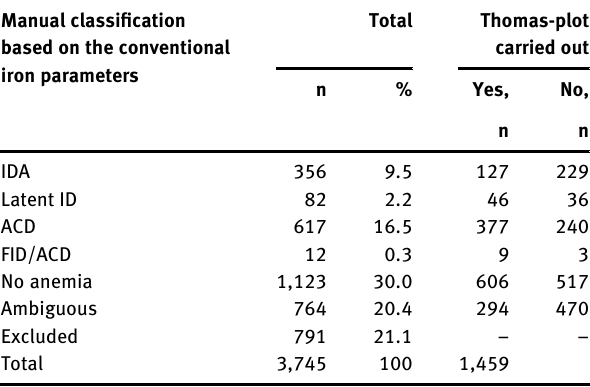
Table  : Results of the manual classi fi cation based on the con- ventional iron parameters (left columns: absolute number [n] and percentage [%], right columns number of patients with TP). Manual classi fi